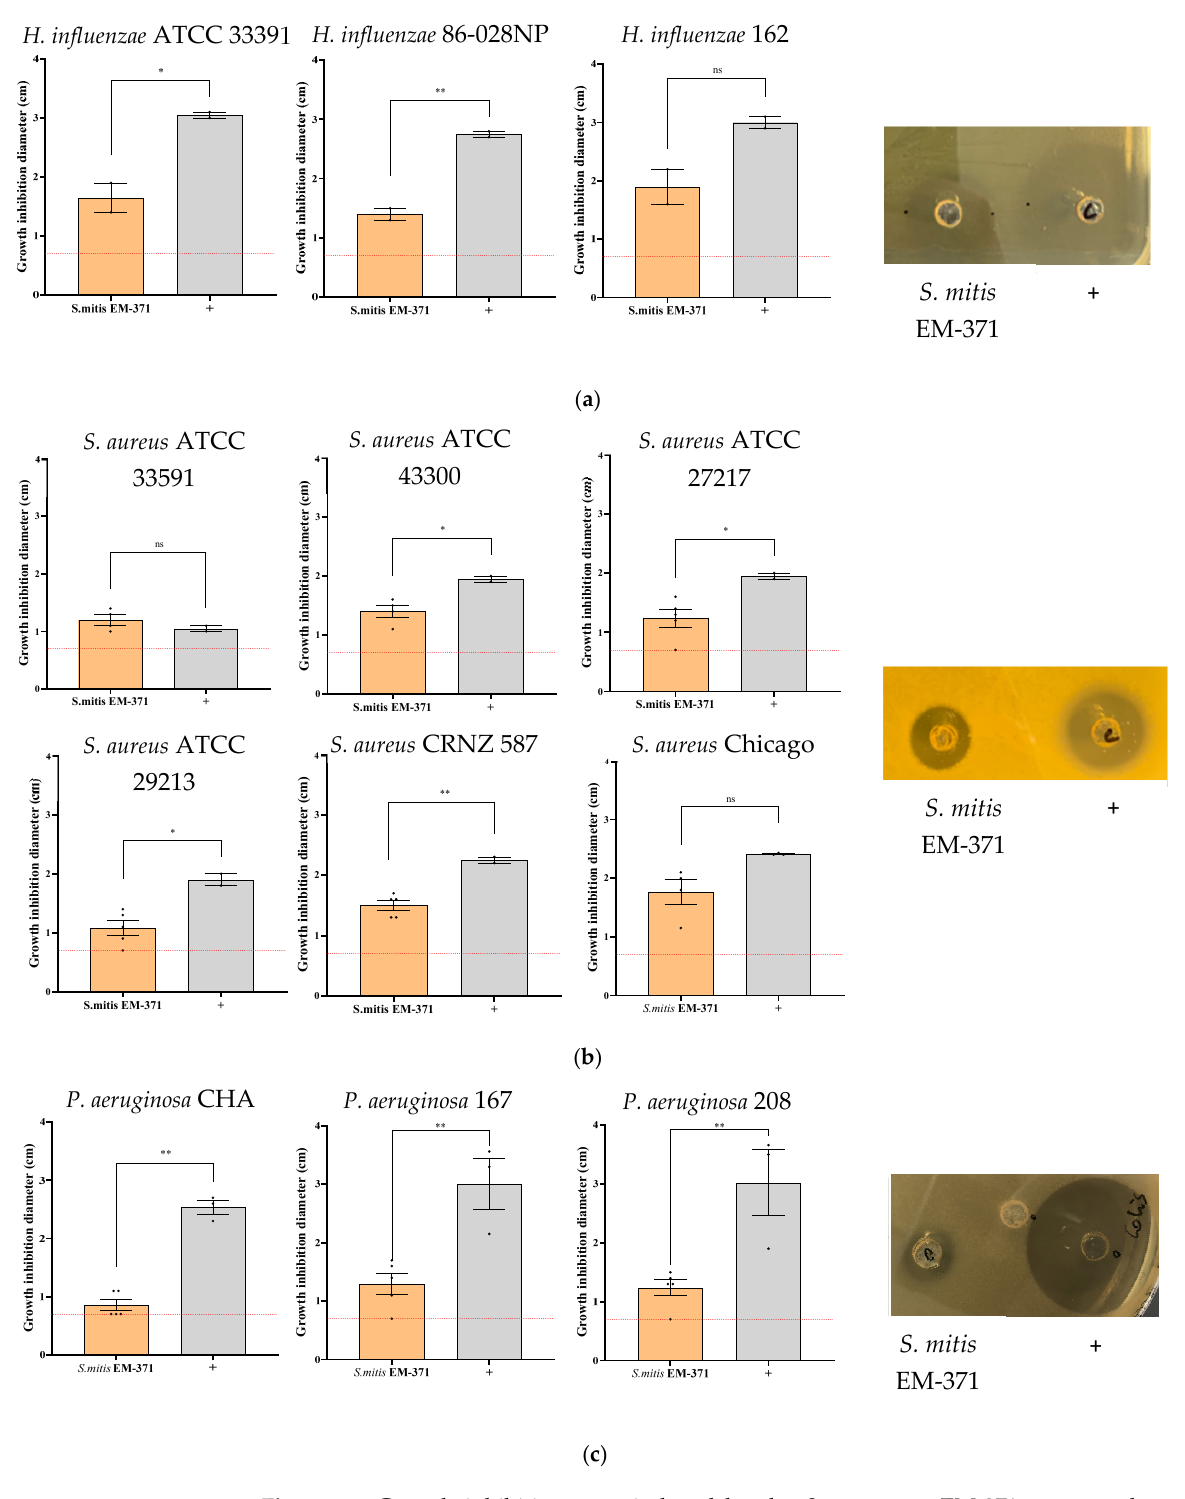
Figure 1. Growth inhibition zone induced by the Streptococcus EM-371 on several strains of ( a ) Haemophilus influenzae , ( b ) Pseudomonas aeruginosa , and ( c ) Staphylococcus aureus . Pictures are representative of at least 2 independent experiments. Graphics represent the mean of the growth inhibition diameter (in cm) in at least 2 experiments. Unpaired t -test was performed with GraphPad version 8 to determine the statistical significance. p -values: *: p < 0.03, **: p < 0.002. +: either chloramphenicol (against H. influenzae and S. aureus strains) or colistin (against P. aeruginosa strains). The red dotted line represents the diameter of the